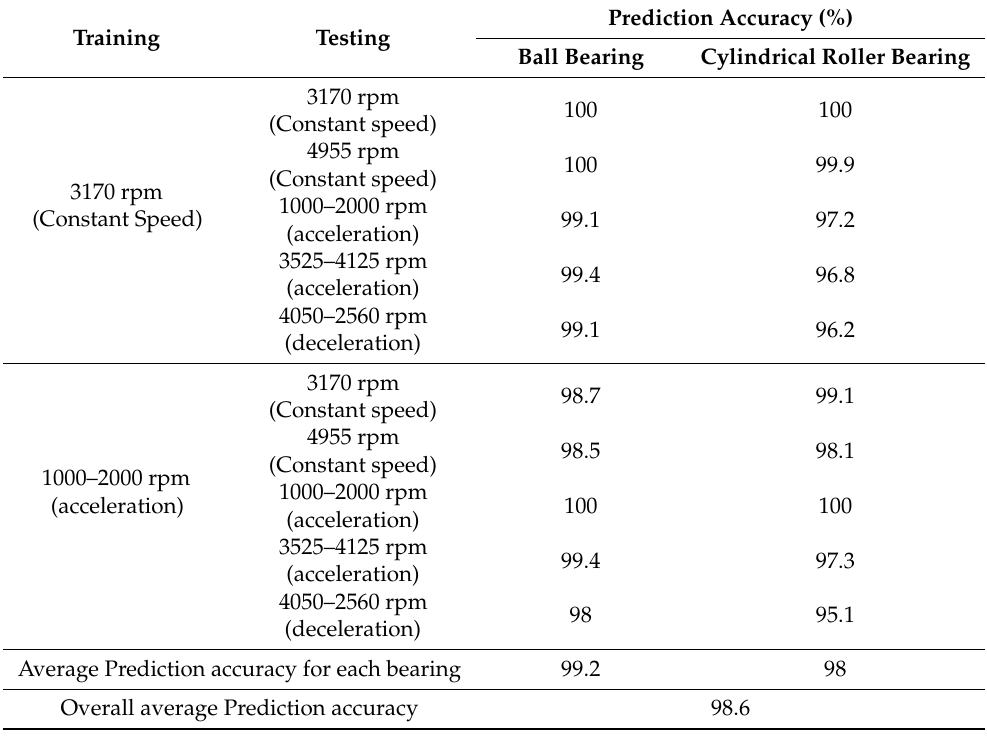
Table 6. Performance of the proposed methodology in terms of prediction accuracy for defect diagnosis under variable speed (case study-2).